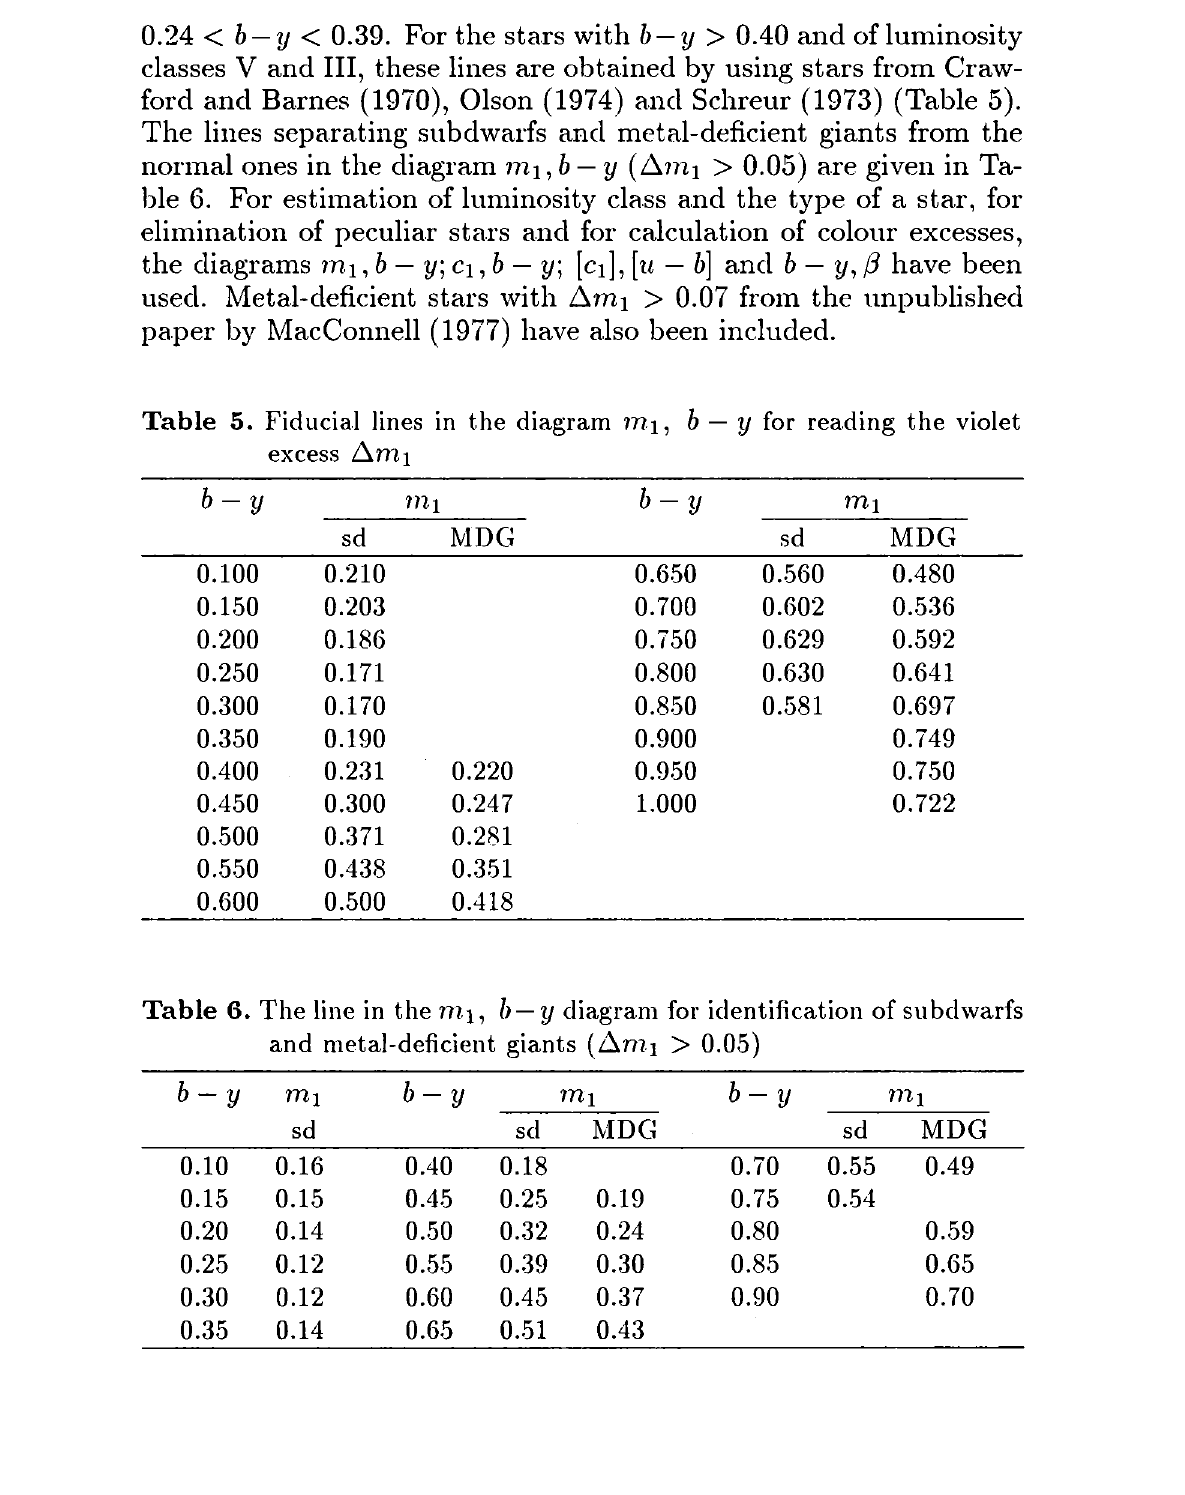
Table 6. The line in the mi, b — y diagram for identification of subdwarfs and metal-deficient giants (Ami >